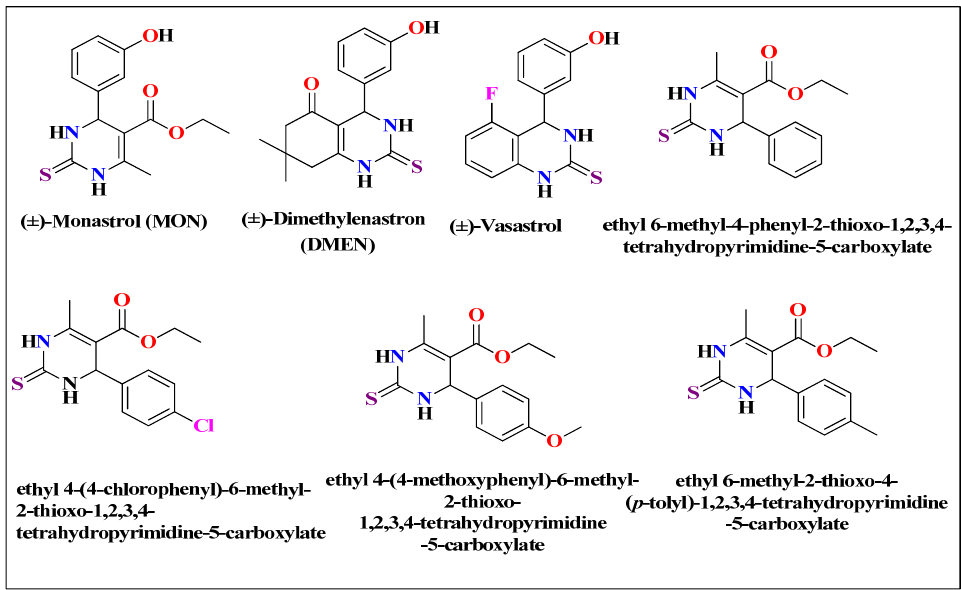
Figure 1. Potent anticancer 3,4-dihydropyrimidine-2(1 H )-thiones derivatives along with Monastrol [15,21–23].